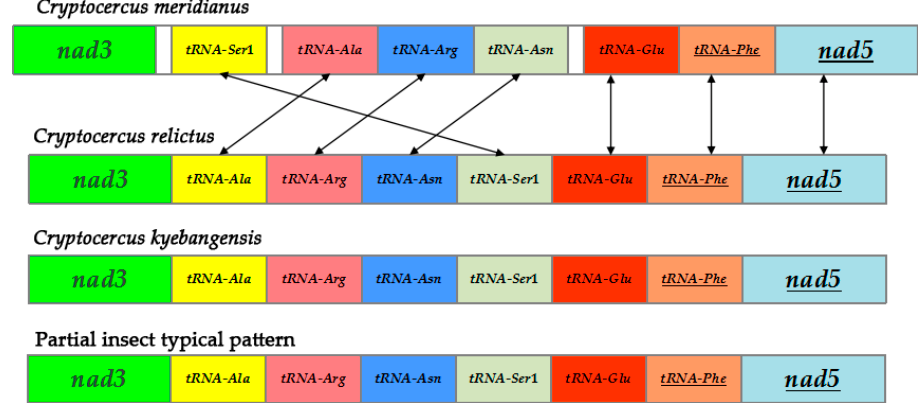
Figure 4. Partial mitochondrial gene arrangements of the three Cryptocercus species along with insect typical pattern. The translocation of tRNA-Ser 1 caused the mitochondrial gene rearrangement of C. meridianus , tRNA-Ser 1 refers to tRNA-Ser AGN . Genes are not drawn to scale but are arranged practically. Three blank areas refer to unusually long intergenic spacer regions which only occur in the mitogenome of C. meridianus . Genes underlined are encoded on the light strand.